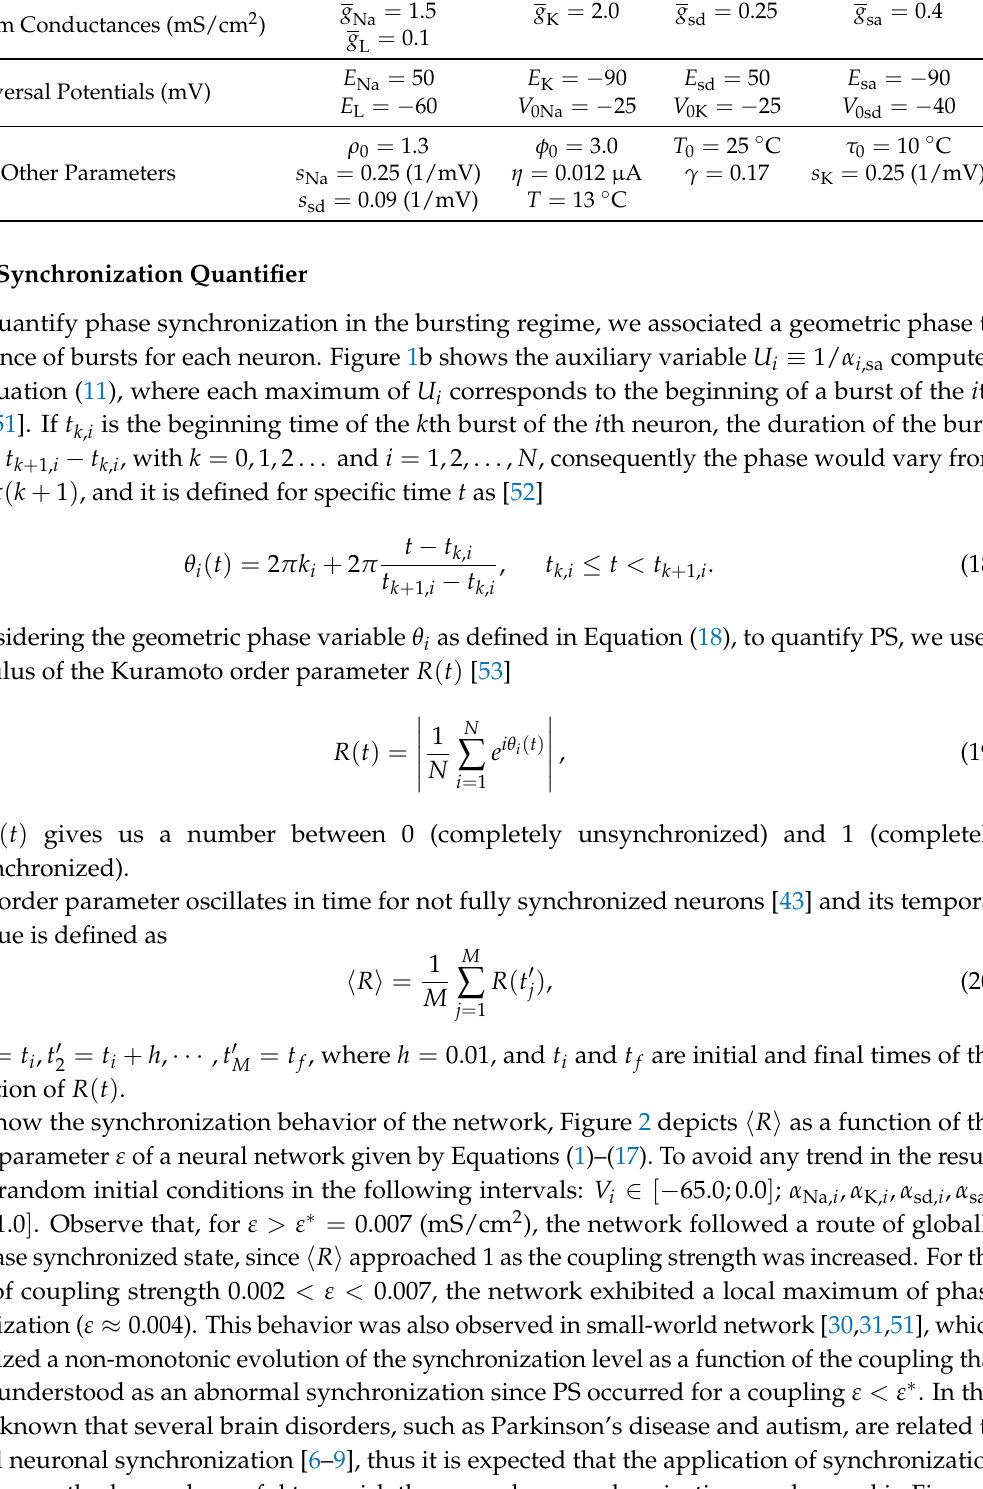
Table 1. Parameter values of the neuronal model according to Braun et al. [25]. Membrane Capacitance C = 1.0 µ F/cm 2 Characteristic Times (ms) τ Na = 0.05 τ K = 2.0 = g Na Maximum Conductances (mS/cm 2 )